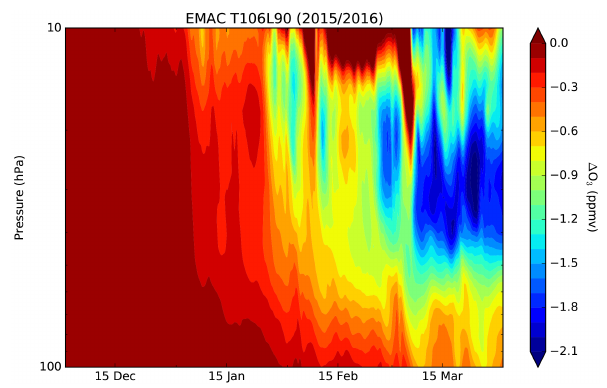
Figure 7. Ozone loss ( (cid:49) O 3 ) as simulated with EMAC T106L90 (difference of O 3 and the passive tracer O ∗ eraged over 70–90 ◦ N) as a function of time and pressure for the 2015/2016 Arctic winter.